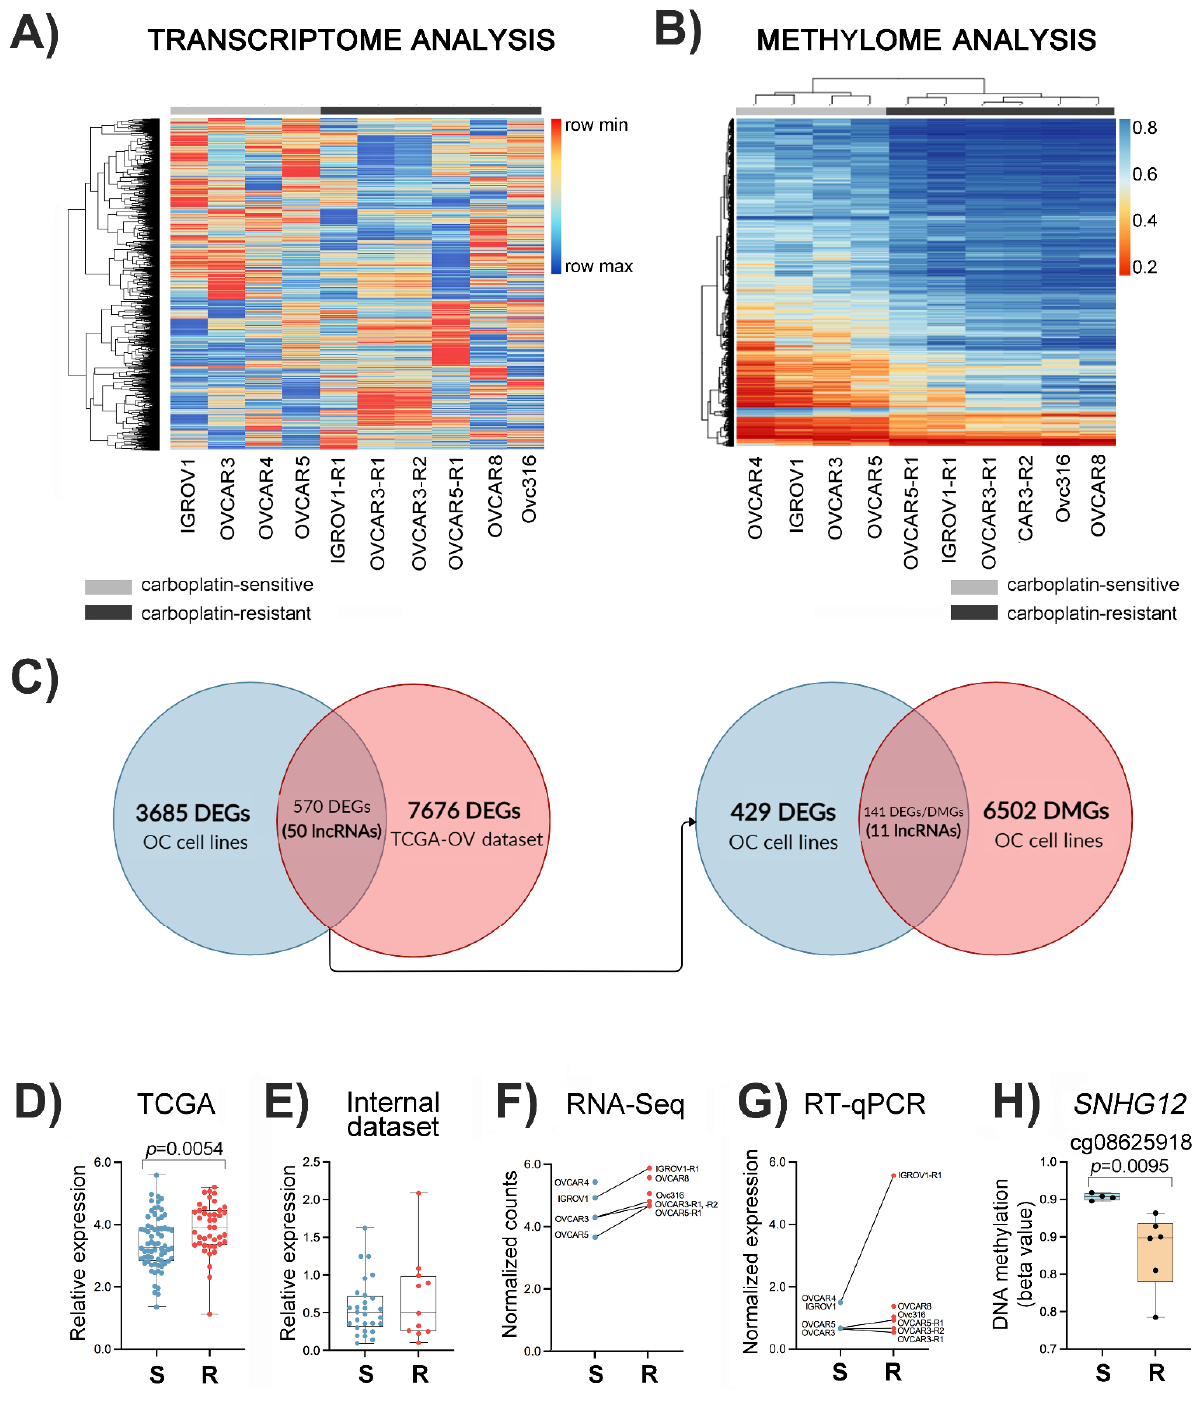
Figure 1. Identification of differentially expressed and methylated lncRNAs associated with carboplatin resistance in ovarian cancer (OC) cell lines. ( A ) Clustering analysis with normalized read counts of 4255 significantly differentially expressed genes (DEGs) in cell lines sensitive and resistant to carboplatin. ( B ) Heatmap with the 5721 DMPs obtained after comparing the resistant and sensi- tive cell lines. ( C ) The Venn diagram shows the intersection between DEGs detected in the ten OC cell lines and TCGA-OV dataset when comparing carboplatin-sensitive and -resistant specimens, including 50 lncRNAs. Integrative transcriptome and methylome analysis revealed that 11 lncRNAs were DEGs and differentially methylated genes (DMGs). The expression levels of the lncRNA